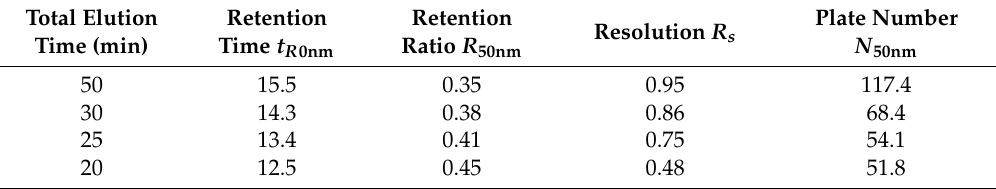
Table 5. Chromatographic separation parameters at different elution times (single measurement).